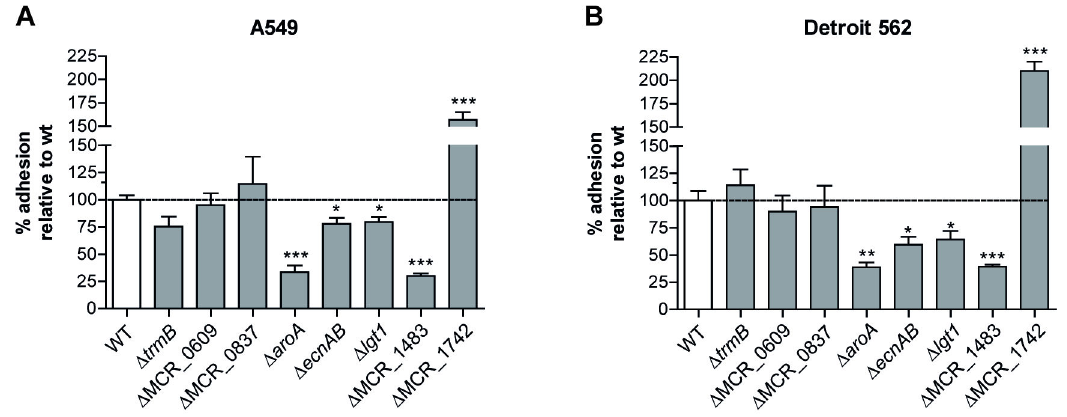
Figure 2. Adhesion of directed gene deletion mutants to respiratory tract epithelial cells. Adherence of aroA, ecnAB , lgt1, and the putative lipoprotein MCR_1483 to both Detroit 562 (A) and A549 (B) cells was significantly attenuated compared to wild- type (WT). Adherence levels are expressed relative to WT (n ≥ 3) and shown as means and SEM. Statistical difference was determined with a Mann-Whitney test with * P < 0.05, ** P < 0.01, and *** P < 0.001. doi: